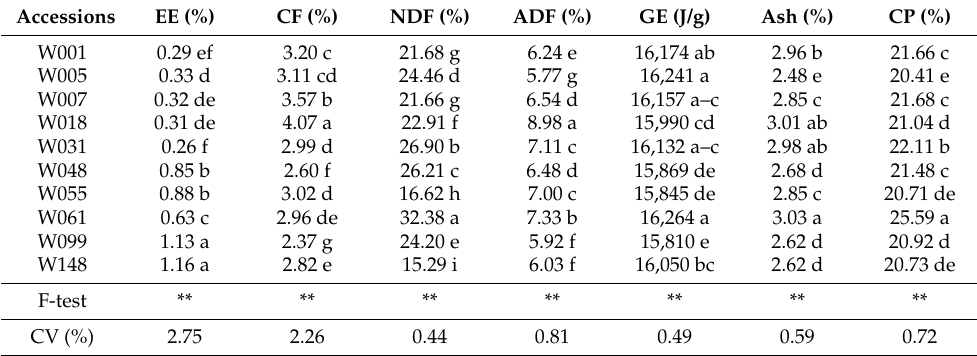
Table 4. Proximate composition of winged bean tubers of ten accessions at Khon Kaen University in the 2019 experiment.